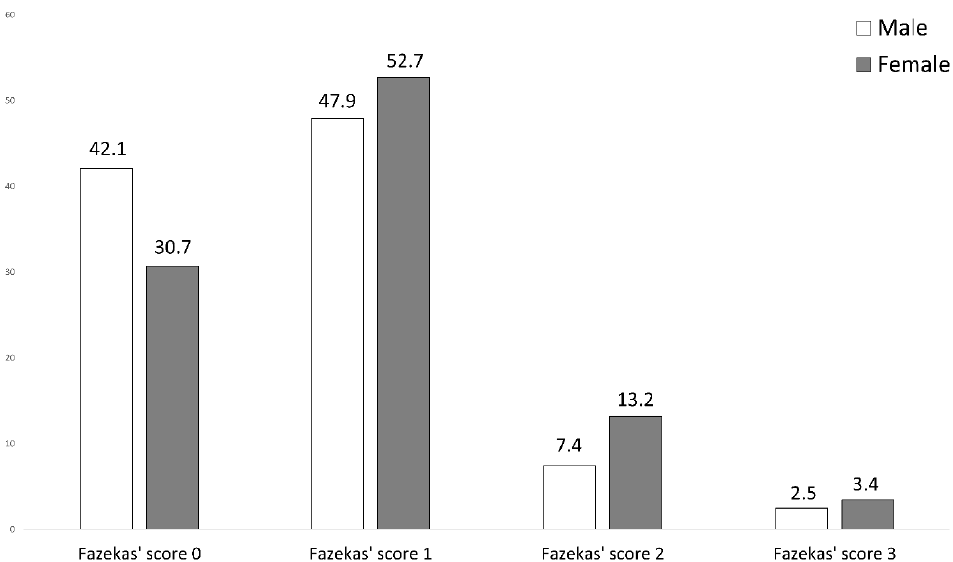
Figure 3. Graduation of cerebral microangiopathy using Fazekas’ score in female TGA patients (grey) compared to male TGA patients (white). Male TGA patients are more likely to have no microangiopathy, while microangiopathy is more common in female TGA patients. Y-axis: Distribution in percent. The numbers given denote the percentage of severity for the corresponding sex.